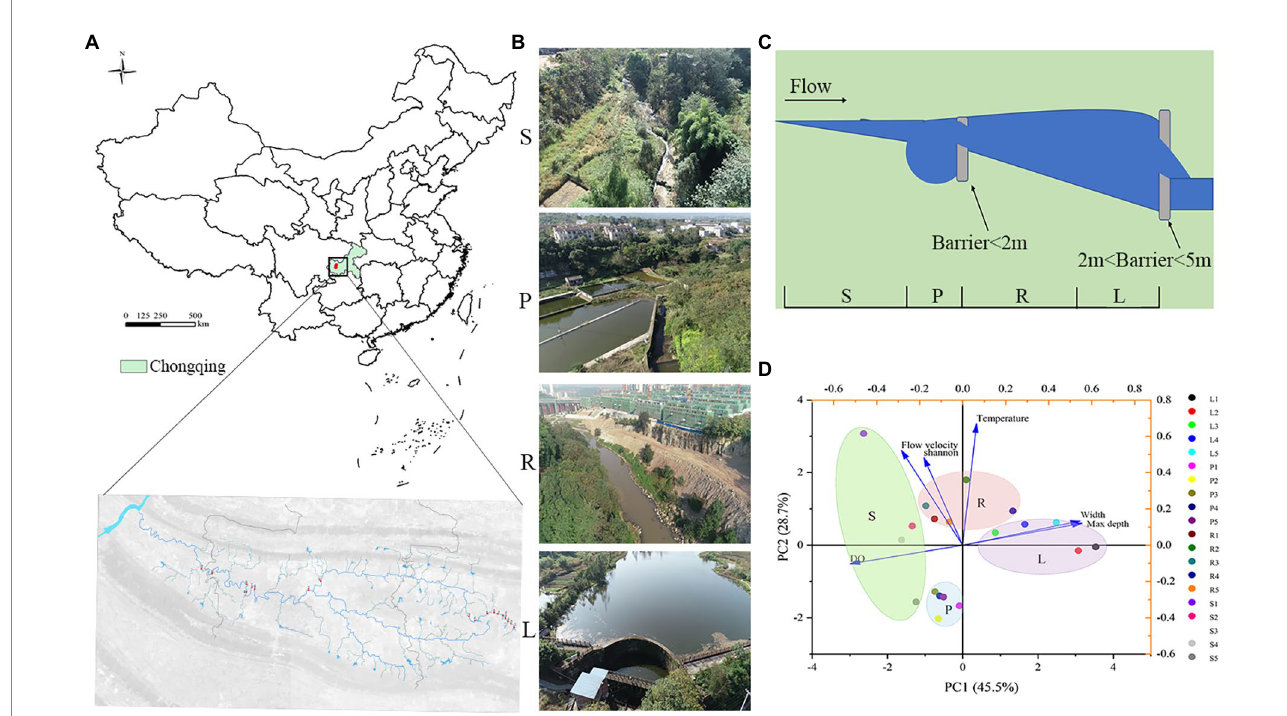
FIGURE 1 According to the height of artificial barriers above the river (lower than 2 m or lower than 5 m), river channels are divided into four habitats. For LB (barriers less than 2 m high), the matrix habitat formed is called ‘pond’ (P), while the patch habitat is called ‘stream’(S). For HB (barriers less than 5 m high), matrix habitat formed by barriers is called ‘lake’ (L), while patch habitat is called ‘river’ (R). (A) Sampling locations of 20 sites on the Liangtan River. (B) Photographs of the sampling sites in this study. (C) Diagram of river channels division. (D) 20 water samples from four habitats were analyzed by Euclidean distance- based principal component analysis